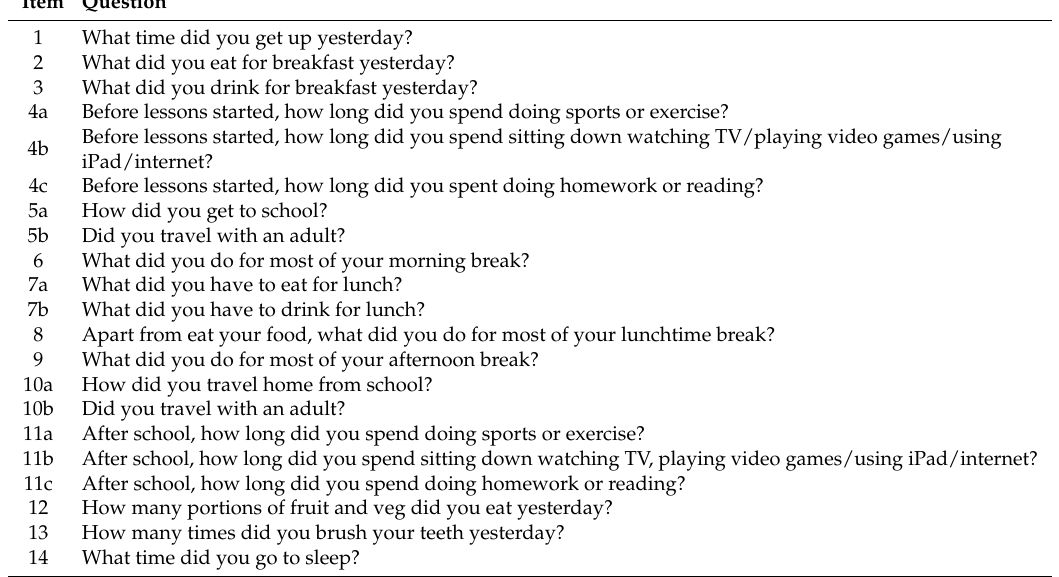
Table 1. Summary of twenty-one items tested for concurrent validity (questions